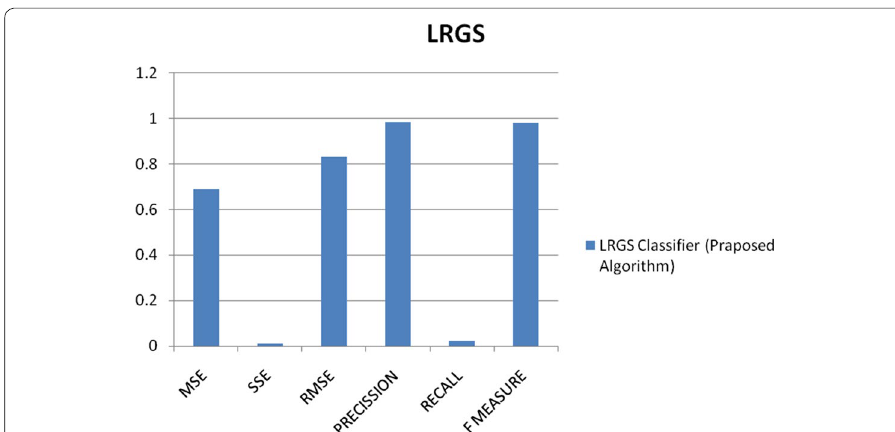
Fig. 8 Different mertics for Proposed (LRGS) classifiers worked on different databases in combination with MIO-TCD